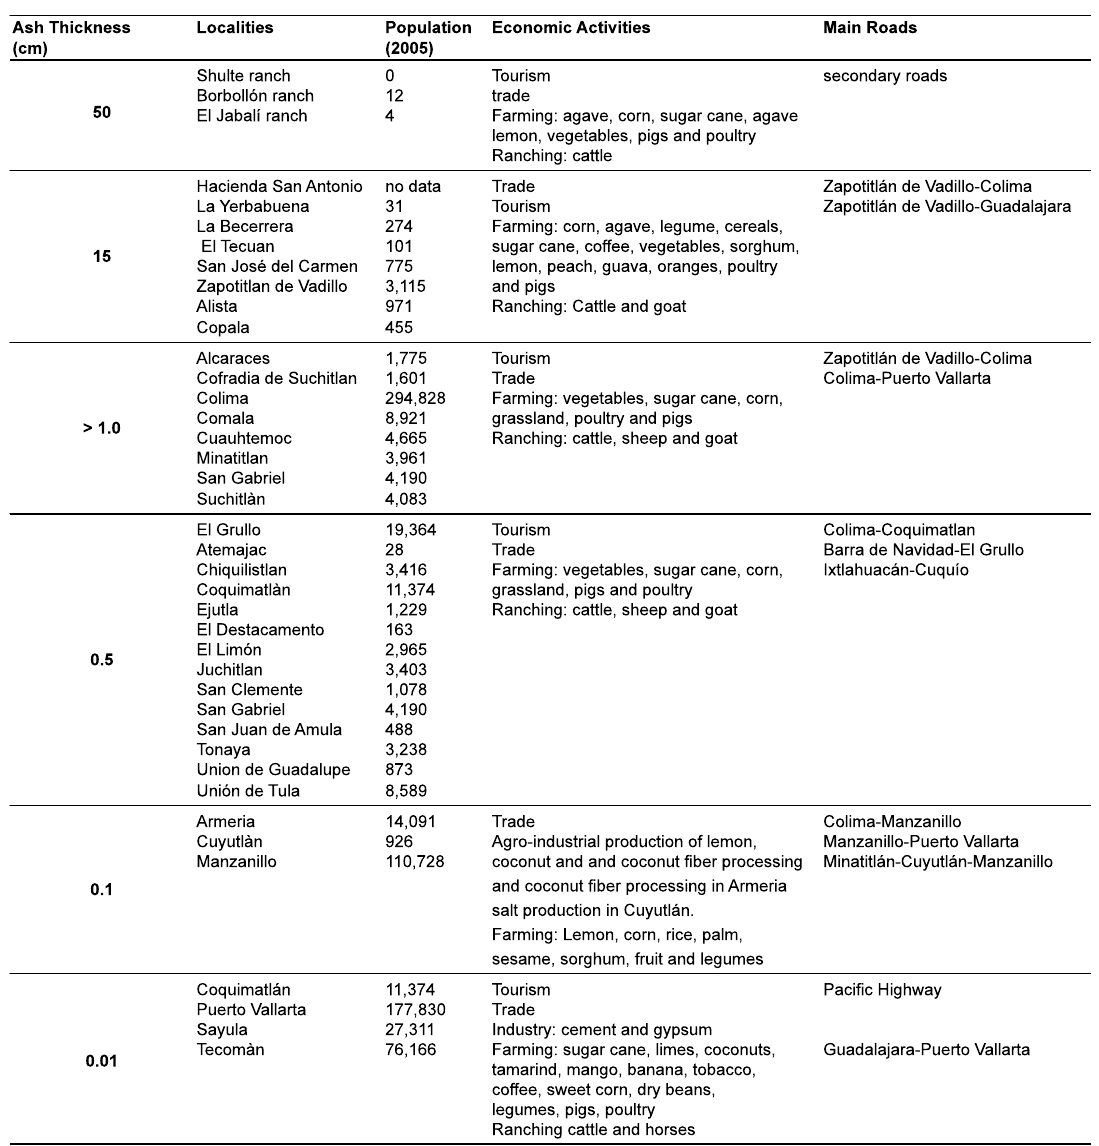
! Table 10. Scenarios 6 and 7. Localities, populations, main economic activities and roads which would be affected by different ash-fall levels during an eruption occurring in September or November and